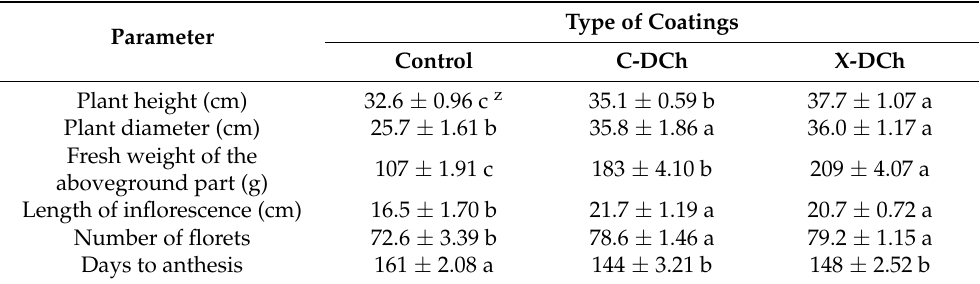
Table 1. Growth and flowering parameters of pineapple lily treated with carrageenan-depolymerized chitosan (C-DCh) or xanthan-depolymerized chitosan (X-DCh).